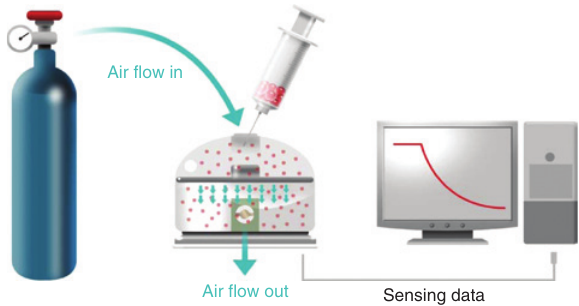
Figure 2: Schematic representation of a SIL-on-QCM gas analysis system for chemoselective gas sensing by specific chemical reactions. can be performed at room temperature and dried ambient air is used as carrier